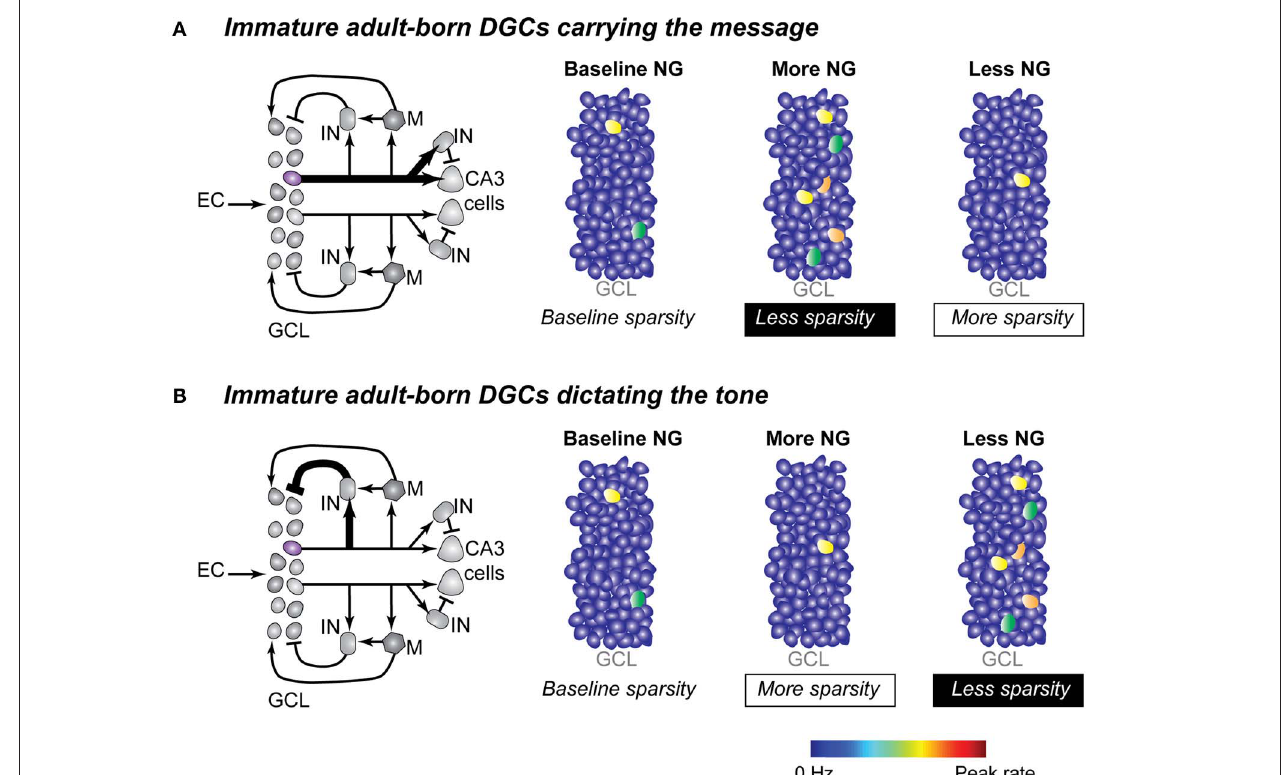
FIGURE 3 | Two possible mechanisms for adult-born DGCs to determine sparsity in the dentate network. (A) Immature DGCs act as the active neuronal population in the DG network. Left panel: simplified local dentate circuit in which the output of one immature DGC (purple) and the output of one mature DGC (gray) are represented. Arrows and bars represent excitatory and inhibitory synapses respectively. Line weight represents signal strength with thicker lines suggesting stronger output strength, through either synaptic strength and/or number of synaptic connections. Right panels: changes in dentate network sparsity as a result of increasing or